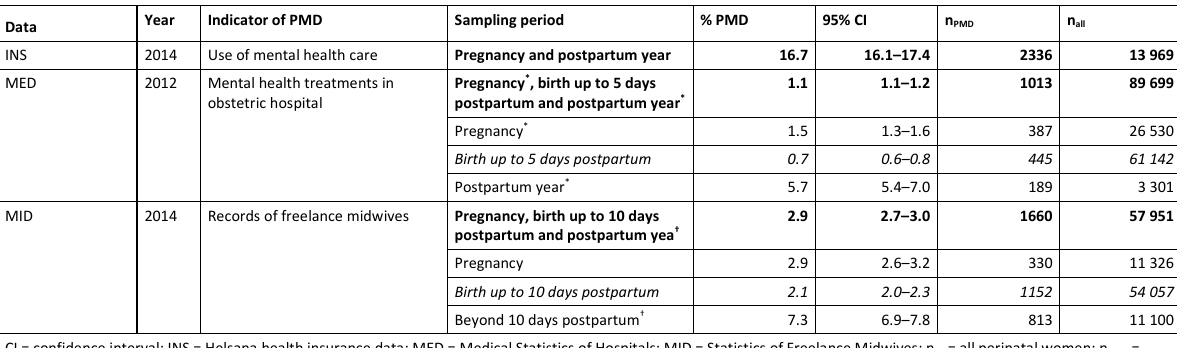
Table 1: Annual prevalence rates of three indicators of perinatal mental disorders. Data